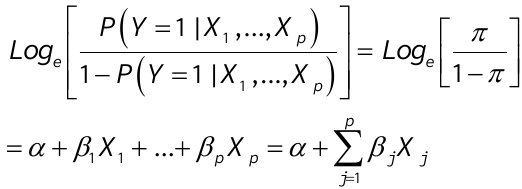
Figure 2: Open-ended CVM question